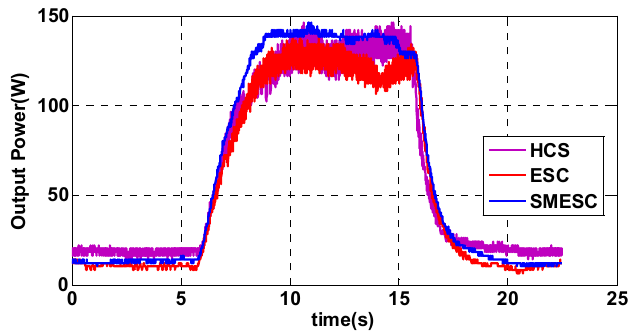
Figure 20. Comparison map of HCS, ESC, SMESC: Wind speed is increased from low to high and then dropped to low again.